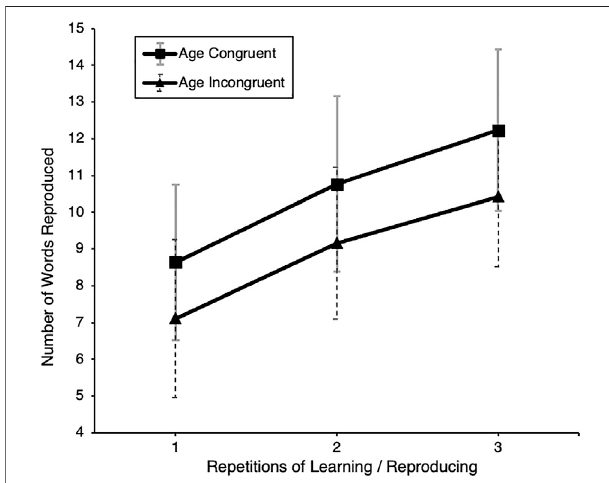
FIGURE 6 | Memory performance (VMR) by experimental condition. Note. Number of reproduced words from the verbal encoding and recall task (VMR) for young sample, displayed separately for the YA y (young avatar) and OA y (old avatar) subgroups over three repetitions of learning and